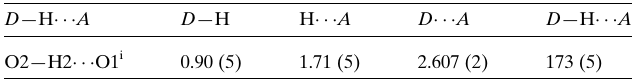
Table 2 Hydrogen-bond geometry (A˚ , (cid:3) ) for